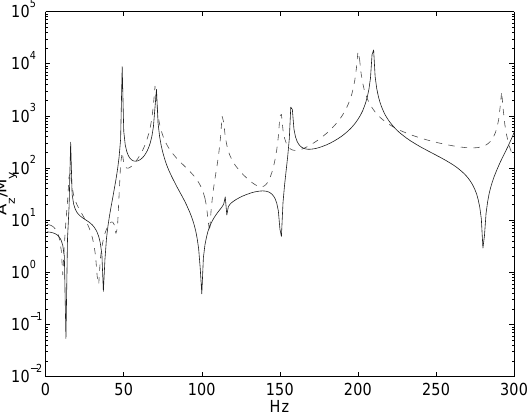
Fig. 5. SEREP expansion of translation/moment frame FRFs: theoretical FRF from FE model (–); SEREP expansion using 10 test points (- -